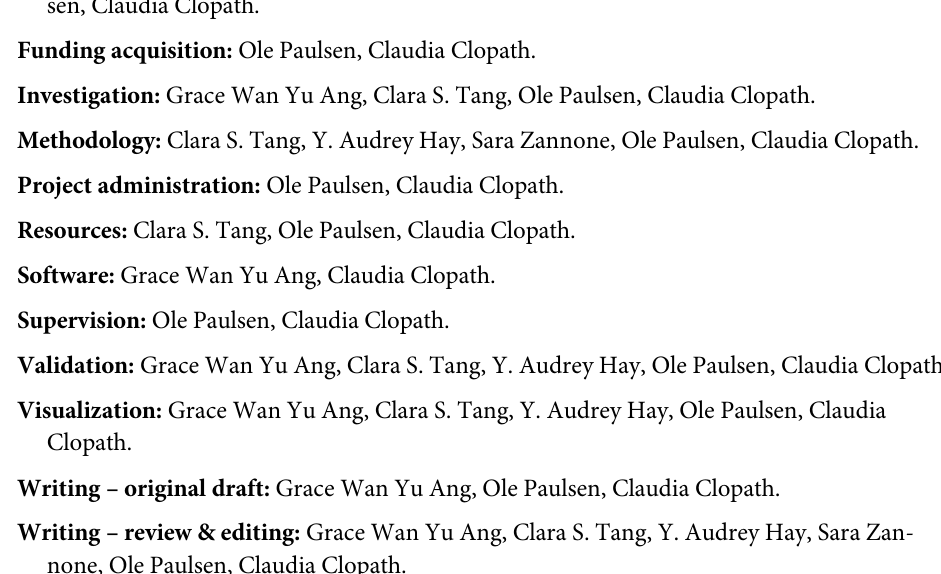
S12 Fig. Effect of agent speed on performance. The effect of increasing agent speed on initial learning and reversal learning, at different acetylcholine levels, when η